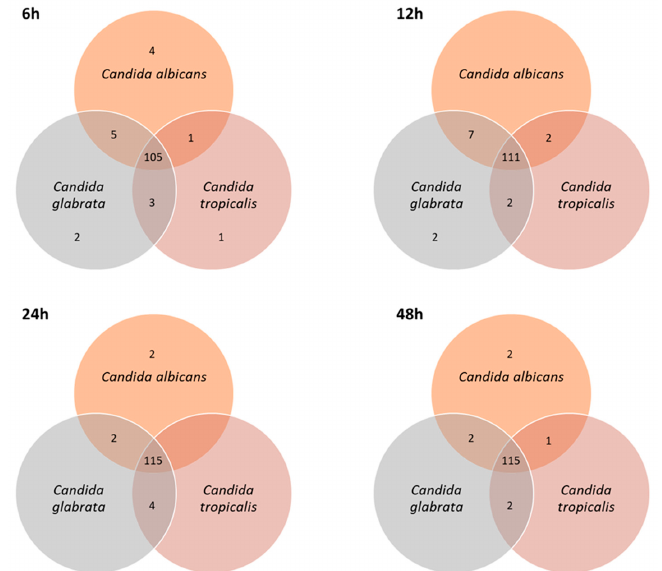
Figure 5. Total number of shared and unique metabolites of each Candida species over the time-course experiment. Only 30% of the identified metabolites were previously reported in the literature for C. albicans